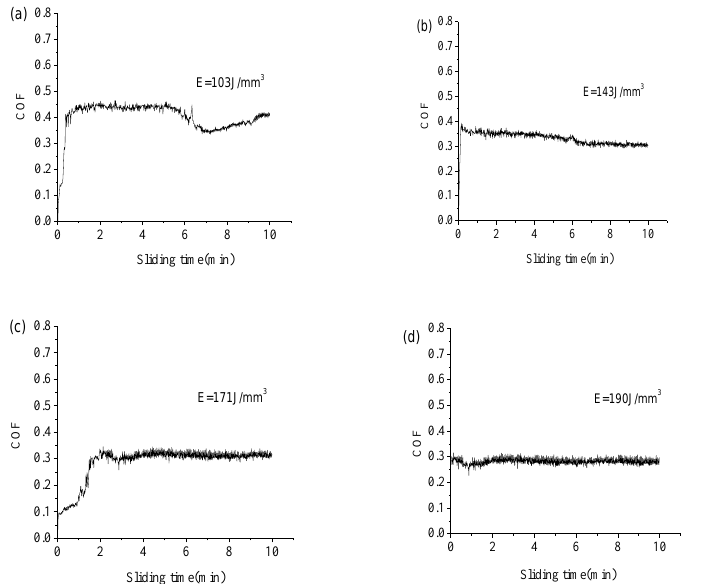
Figure 13. COF of the SLM as-built parts under different E over the sliding time. ( a ) COF of the SLM as-built parts under E =103 J/mm 3 over the sliding time; ( b ) COF of the SLM as-built parts under E = 143 J/mm 3 over the sliding time; ( c ) COF of the SLM as-built parts under E = 171 J/mm 3 over the sliding time; ( d ) COF of the SLM as-built parts under E = 190 J/mm 3 over the sliding time.